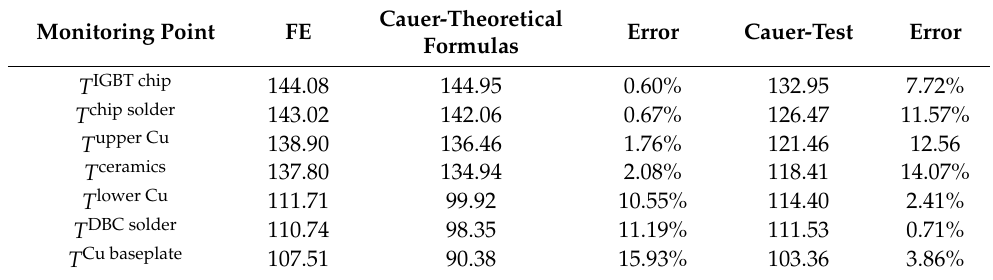
Figure 17. Comparison of the Cauer model calculation results and FE calculation results for each material layer under DC-2 conditions. Table 7. Verification of the Cauer thermal network models under DC-2 conditions by FE analysis.